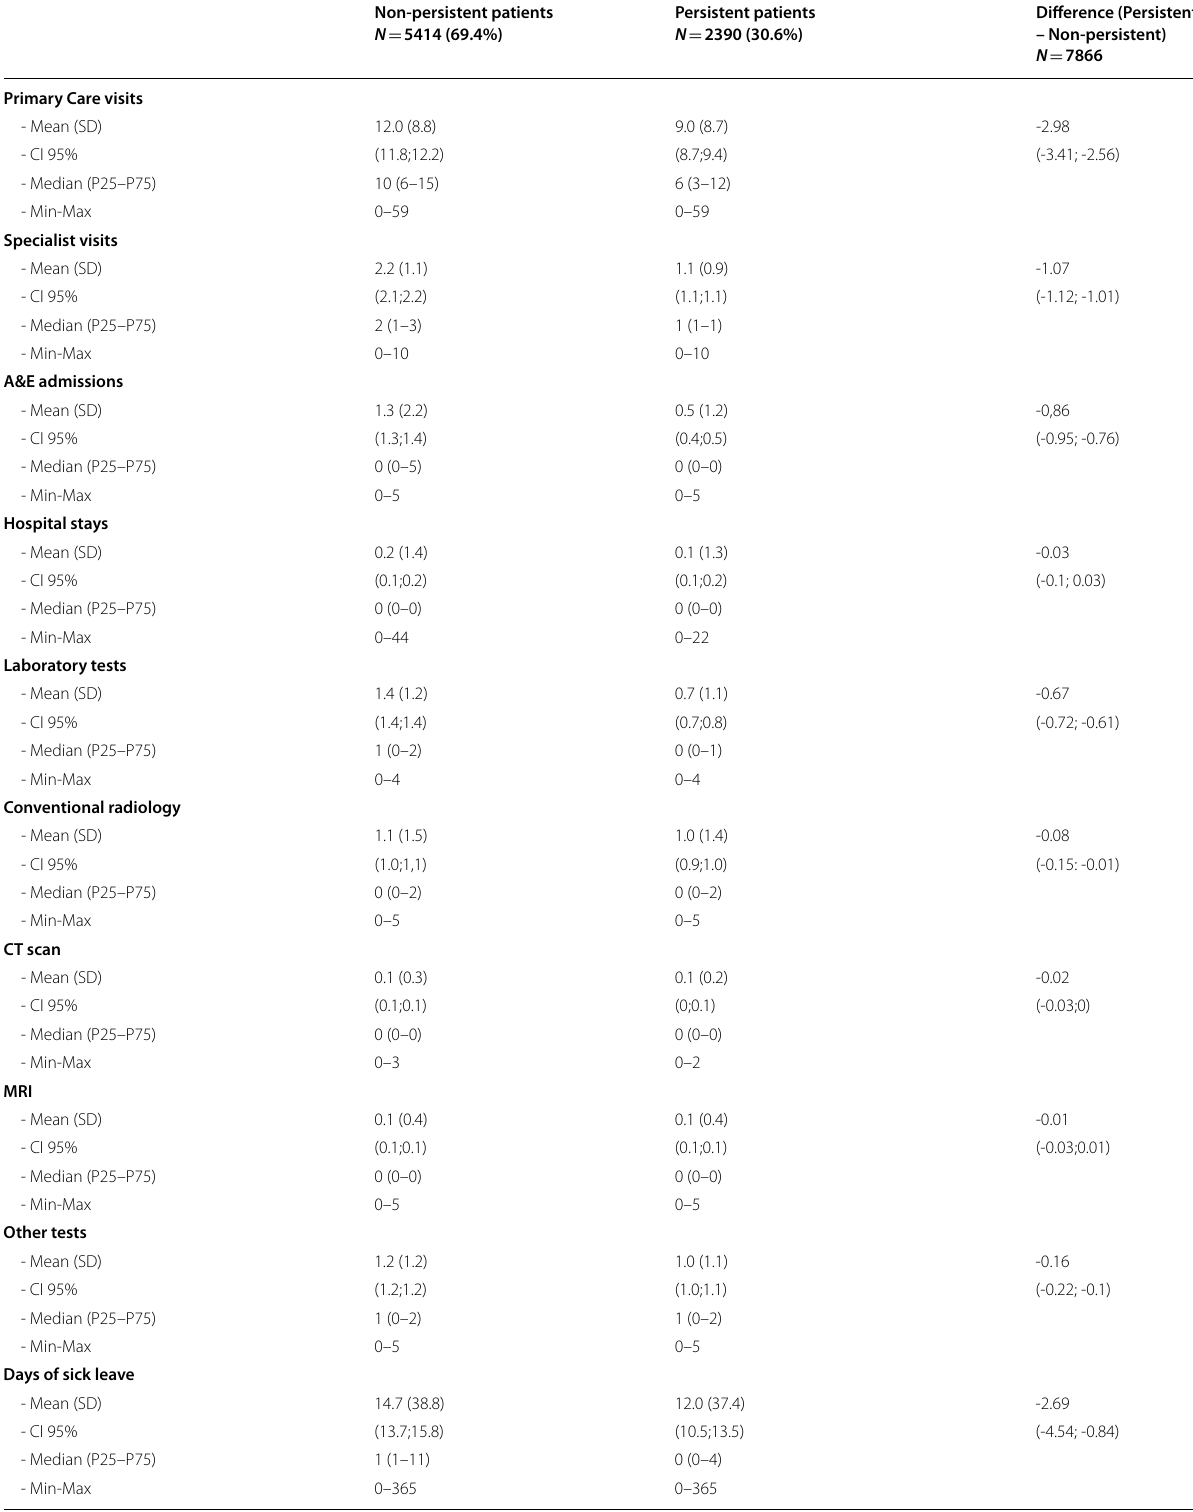
Table 3 Use of healthcare